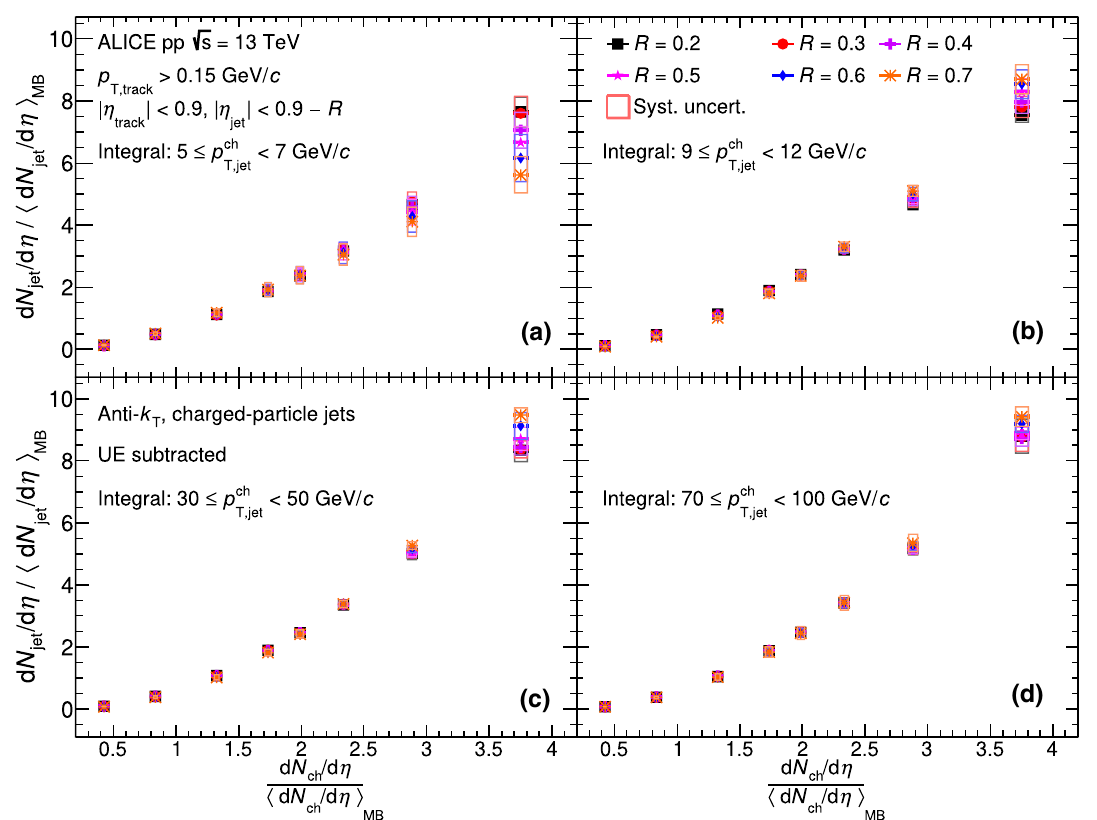
Fig. 13 Self-normalised jet yields as a function of the self-normalised charged-particle multiplicity for different resolution parameters R var- ied from 0 . 2 to 0 . 7 in different jet p T intervals: 5 ≤ p ch